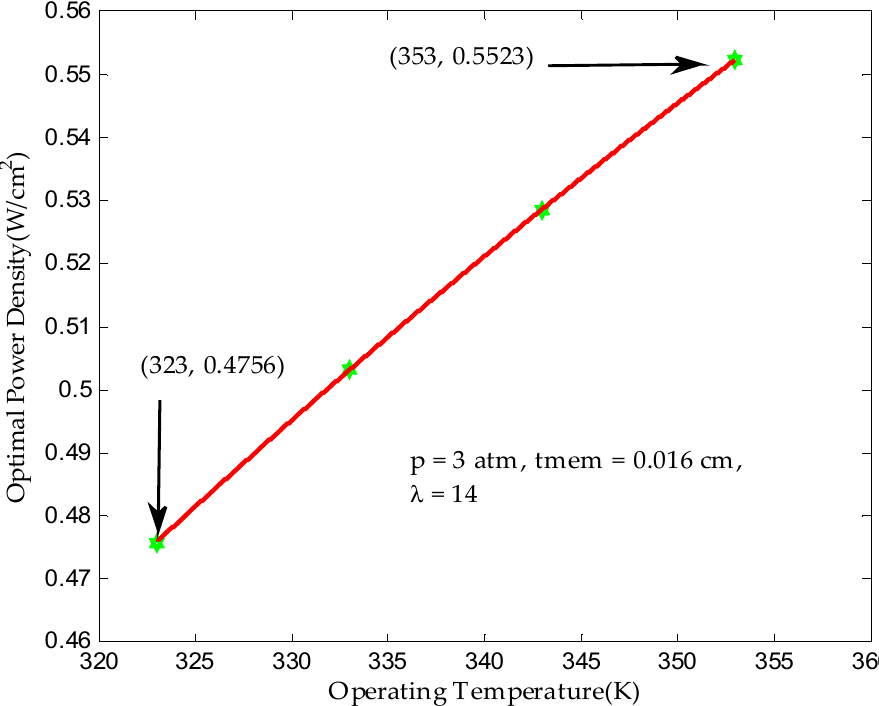
Figure 3. Optimal output power density varying with operating temperature.